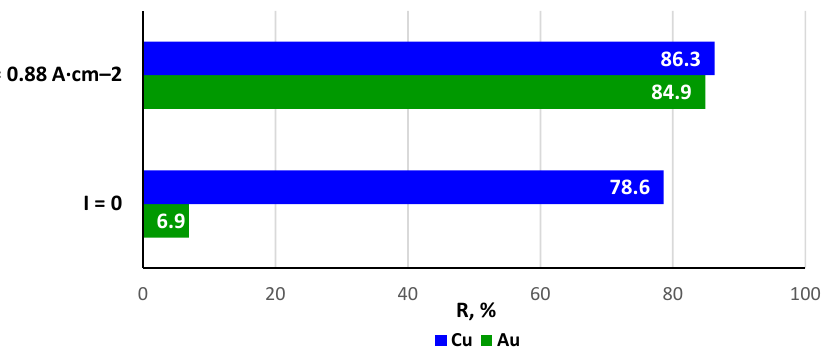
Figure 10. Effect of AC applying on gold and copper leaching degree. Experimental conditions: Raw material—fraction [A], t ex = 2 h, S/L = 8.6 g · L –1 , and C HCl = 6 M.